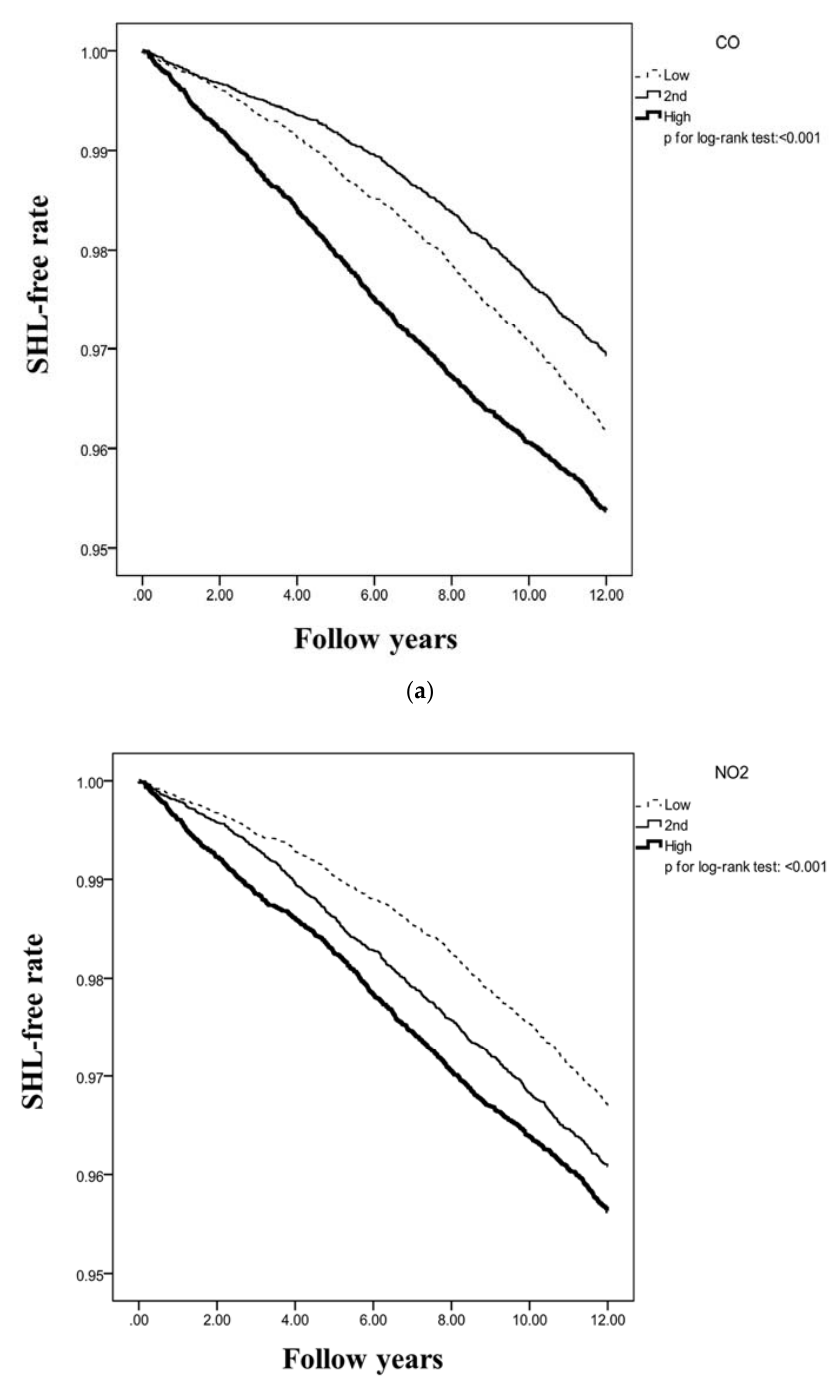
Figure 1. Probability free of SHL among three levels (Low, 2nd or High level) of pollutants Figure1. ProbabilityfreeofSHLamongthreelevels(Low, 2ndorHighlevel)ofpollutantsconcentrations: concentrations: ( a ) CO; ( b ) NO 2 . ( a ) CO; ( b ) NO 2